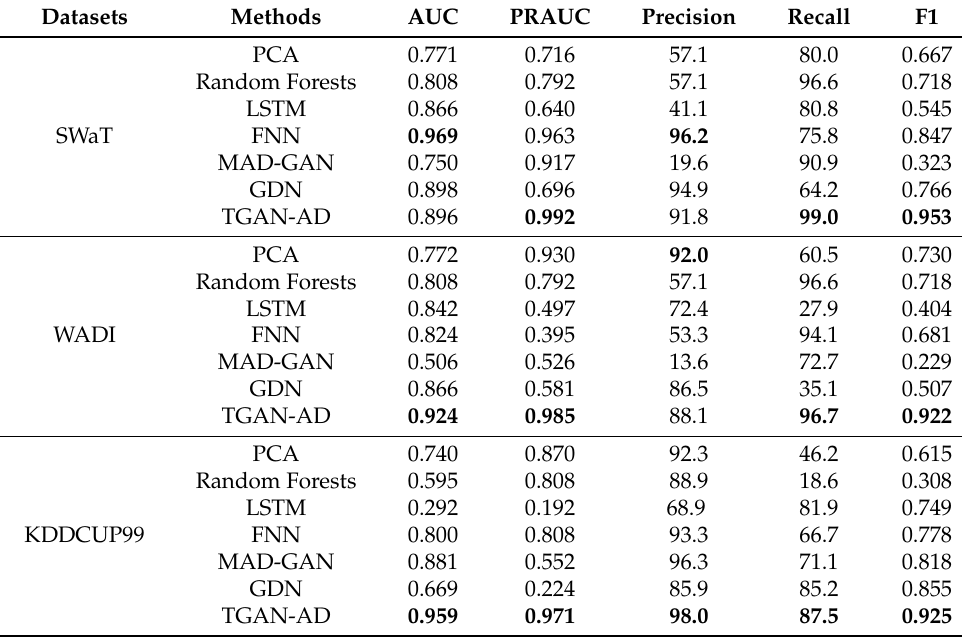
Table 2. Anomaly detection metrics for different